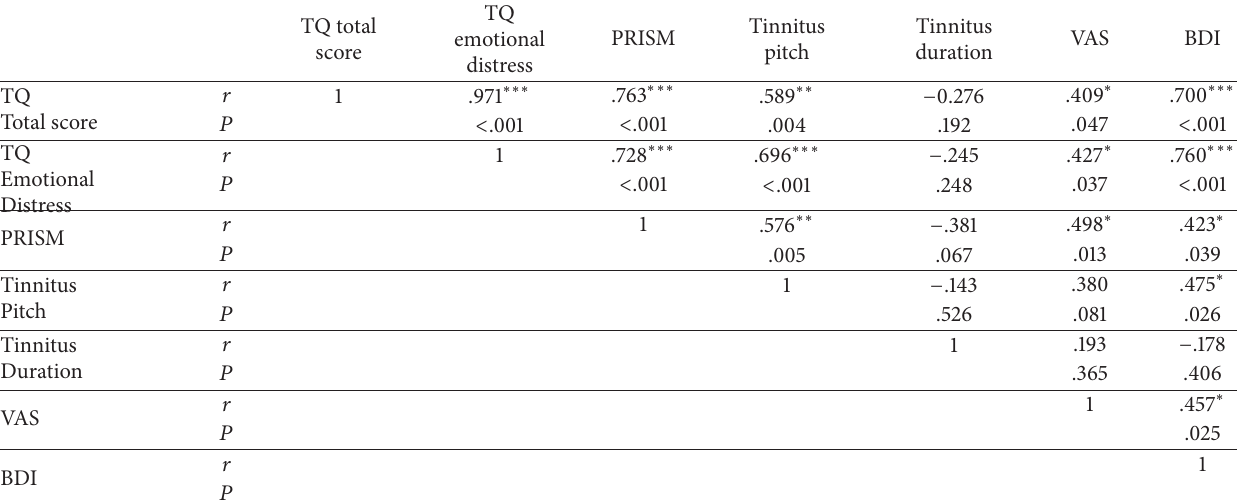
Table 2: Correlations between various tinnitus-related